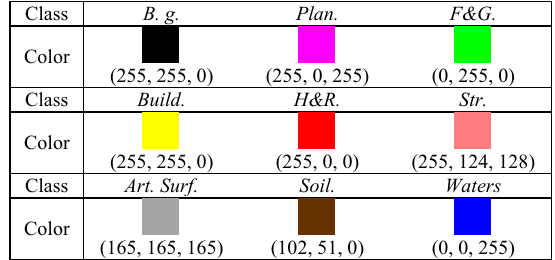
Table 3. The land cover classes and corresponding colors on labels